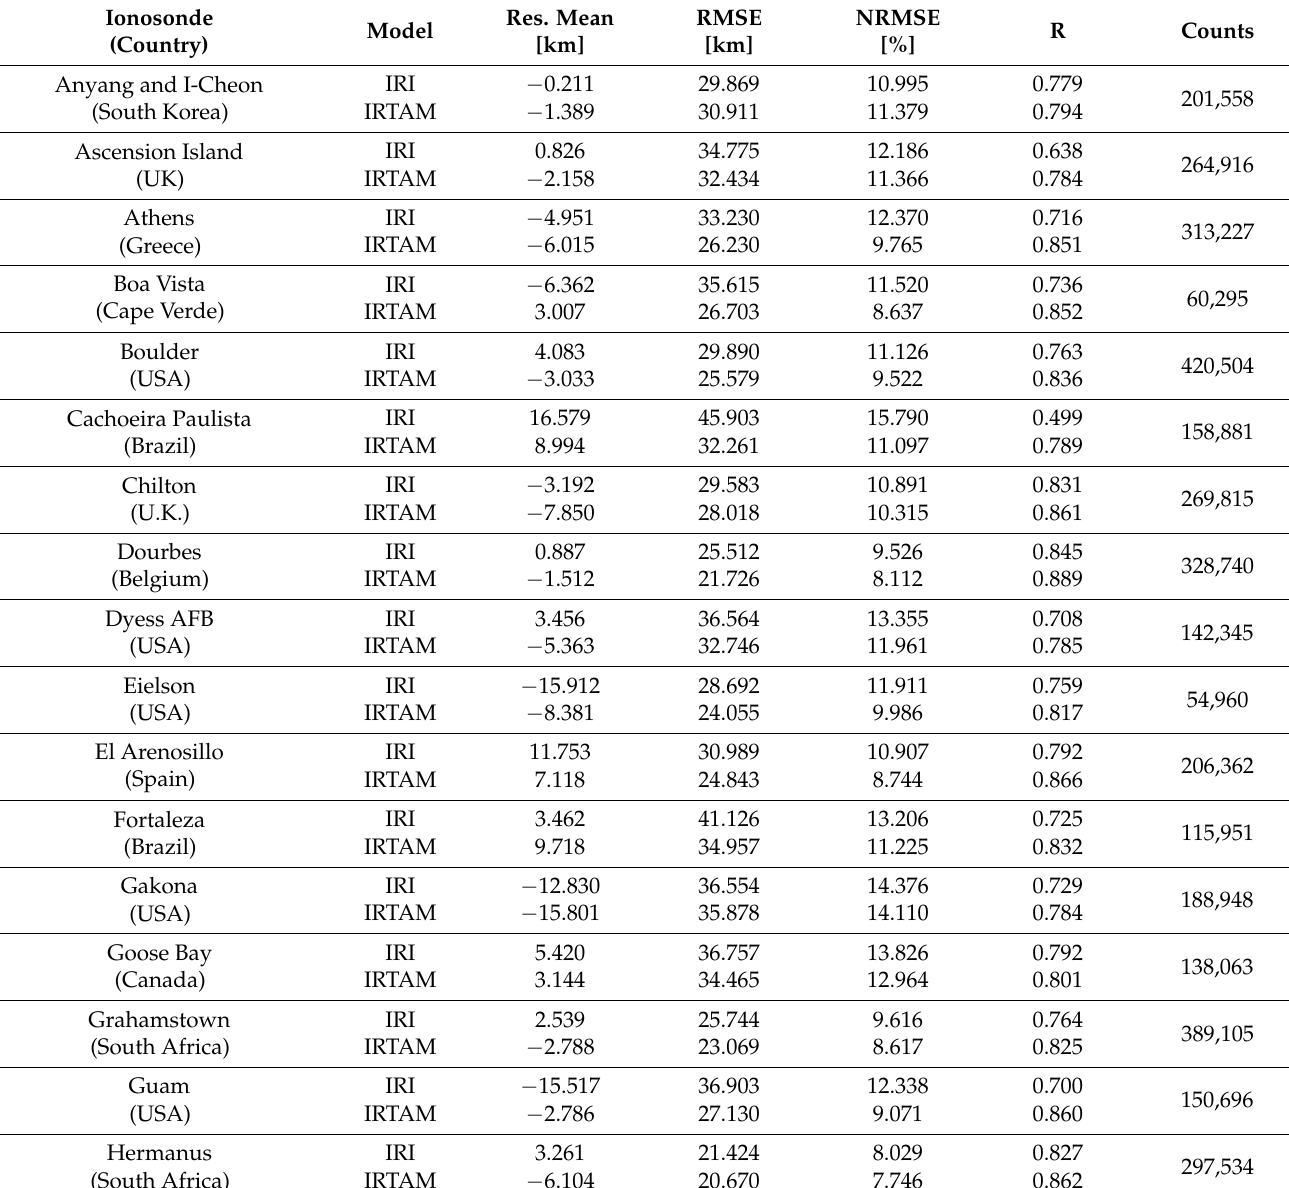
Table 6 shows the statistical parameters (1–4) calculated for the hm F2 time series recorded in each of the 40 ionosonde stations listed in Table 1. Differently from the fo F2 results shown in Table 3, the number of cases for which Res.Mean IRI < Res.Mean IRTAM and for which Res.Mean IRTAM < Res.Mean IRI is practically the same. This circumstance is in accordance with the very similar IRI (1.804 km) and IRTAM ( − 1.619 km) Res.Mean absolute values calculated when the whole hm F2 ionosonde dataset is considered (bottom row of Table 5). This fact points out that the two models are practically equivalent in terms of accuracy. Nonetheless, the IRTAM RMSE and NRMSE values are always lower than the IRI ones, with the exception of the stations of Anyang and I-Cheon, Kwajalein, and Rome. This fact highlights that IRTAM models hm F2 with a precision better than that of IRI. Table 6. Same as Table 5, but for each of the hm F2 datasets relative to the 40 ionosonde stations listed in Table 1. The number of counts on which the statistics were calculated is reported in the rightmost